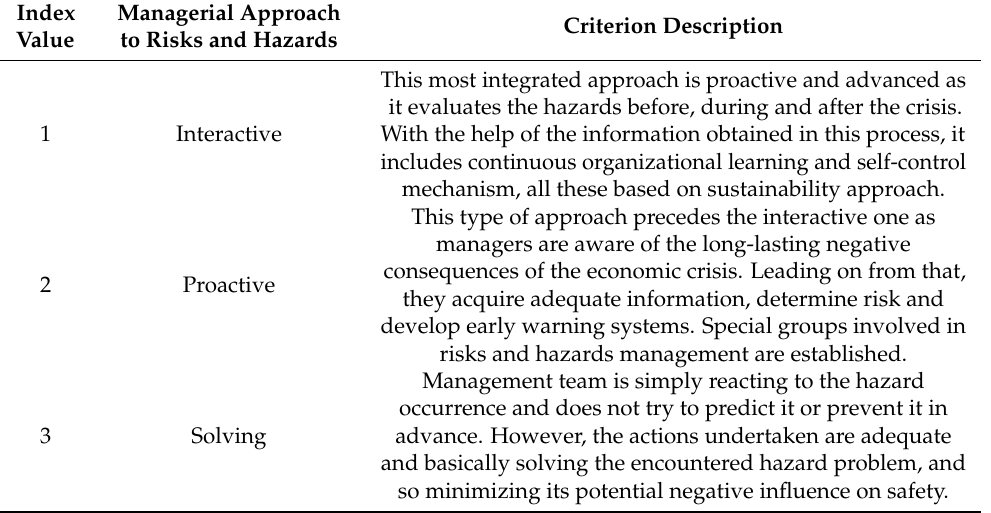
Table 3. Proposed classification table for a managerial approach to risks and hazards index— A , own work based on